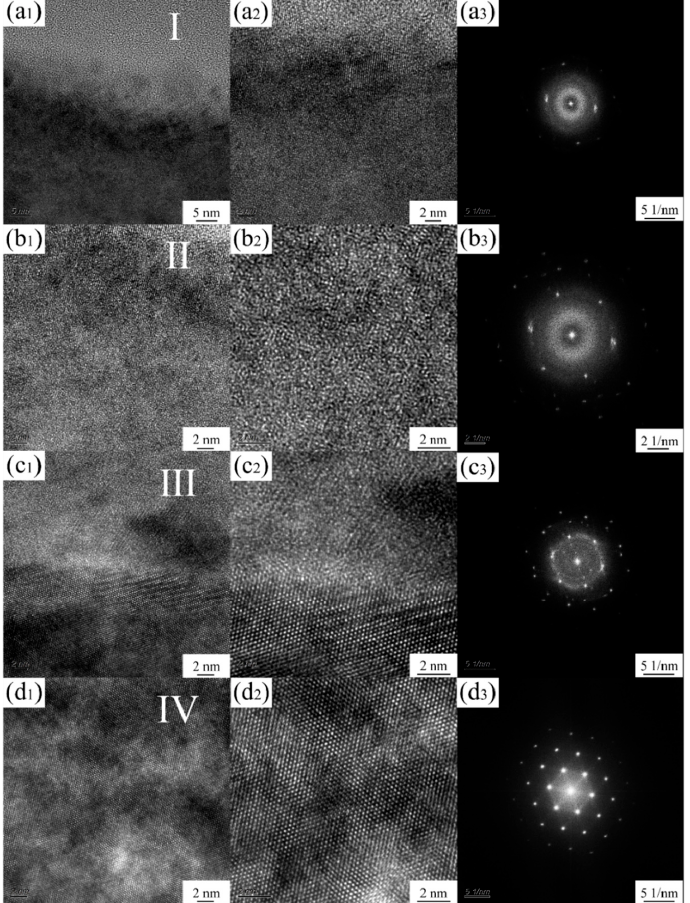
Figure 8. High resolution TEM (HR-TEM) images and Fourier transform images for four different regions of Ag-implanted layer from surface to inside: ( a 1 –a 3 ) HR-TEM images and Fourier transform image for Region Ⅰ ; ( b 1 –b 3 ) HR-TEM images and Fourier transform image for Region Ⅱ ; ( c 1 –c 3 ) HR-TEM images and Fourier transform image for Region Ⅲ ; ( d 1 –d 3 ) HR- TEM images and Fourier transform image for Region Ⅳ .